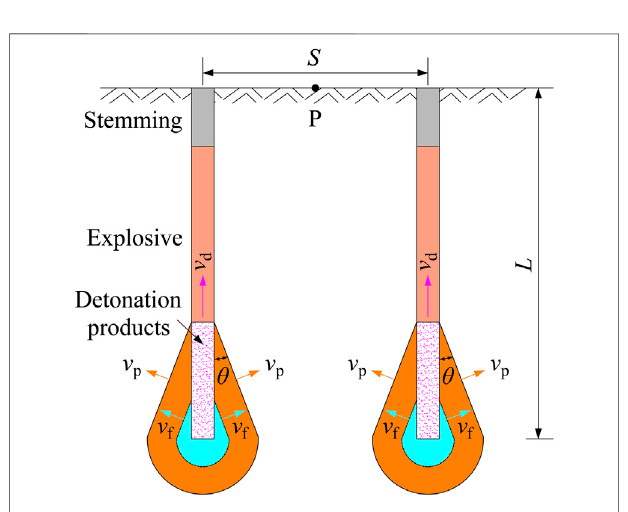
FIGURE 2 | Diagram of the mach cone formation around